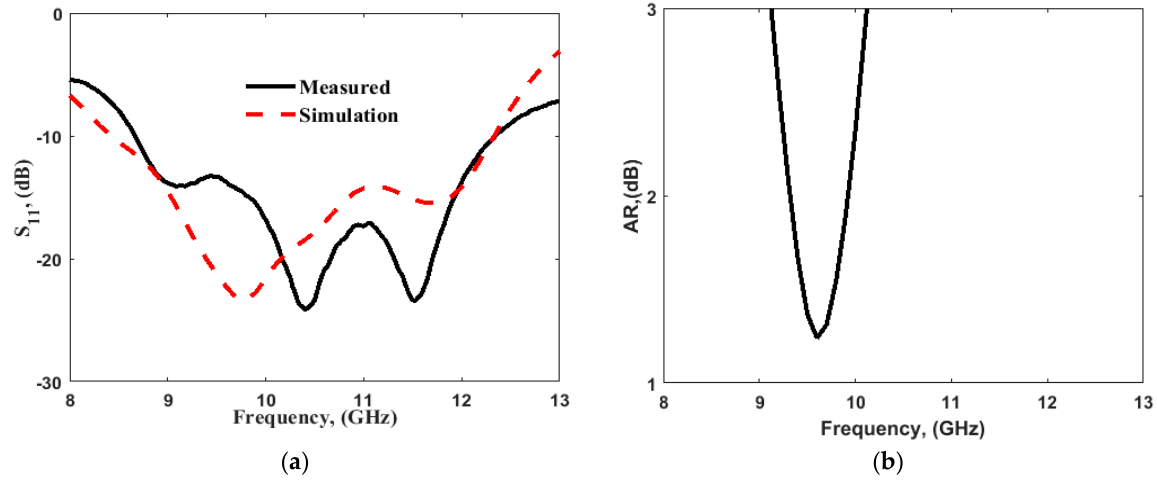
Figure 2. ( a ) Simulated and measured S-parameter response; ( b ) AR for single-element DRA.